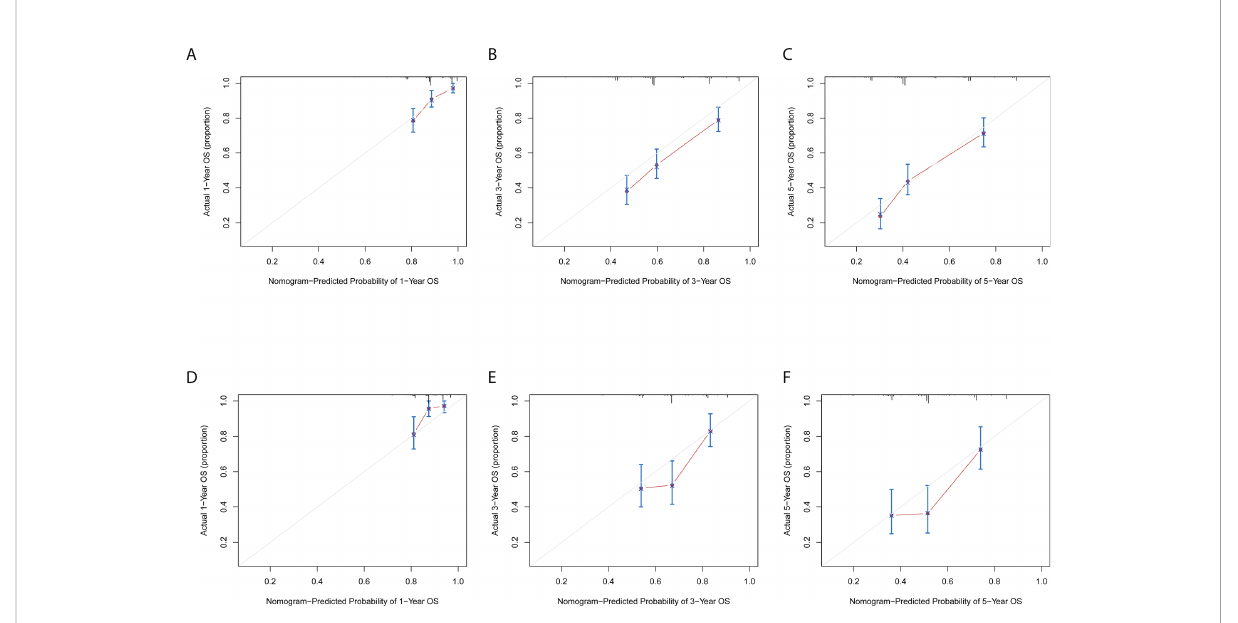
FIGURE 3 Calibration Curve for training group and validation group. The calibration curve for predicting the 1-year, 3-year, and 5-year survival probability of GC patients in the training cohort (A – C) and the validation cohort (D – F) . Nomogram-predicted probability of overall survival is plotted on the x-axis; actual overall survival is plotted on the y-axis.